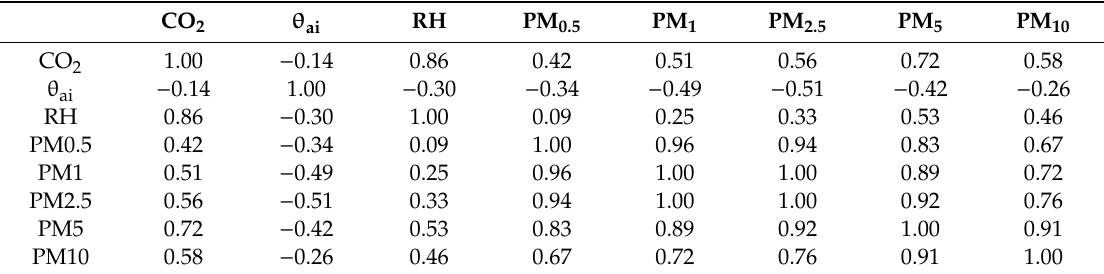
Table 4. Correlation matrix ( p < 0.05).